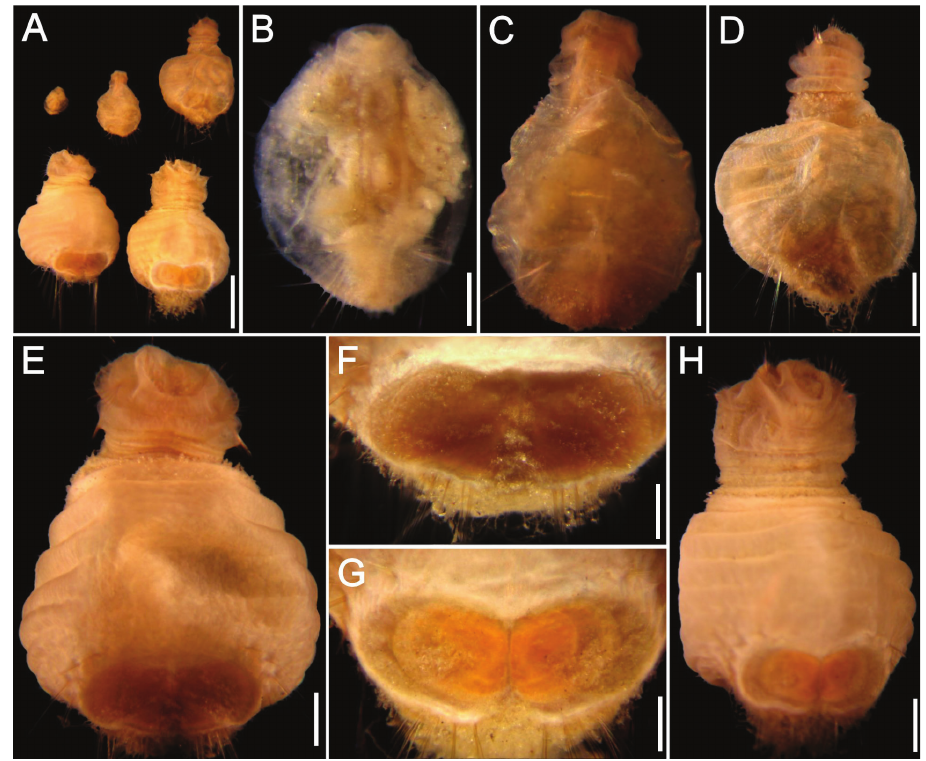
Figure 10. Sternaspis williamsae sp. n. Juveniles (LACM 5357) A Complete specimens, ventral view B Smallest juvenile, ventral view C Second specimen, ventral view D Intermediate-sized juvenile, ventral view E Second largest specimen, ventral view F Same, ventro-caudal shield, oblique illumination G Larg- est specimen, ventral view H Same, ventro-caudal shield, incident illumination. Bars: A 1.4 mm B 0.1 mm C 0.2 mm D, G 0.6 mm E 0.5 mm F, H 0.3